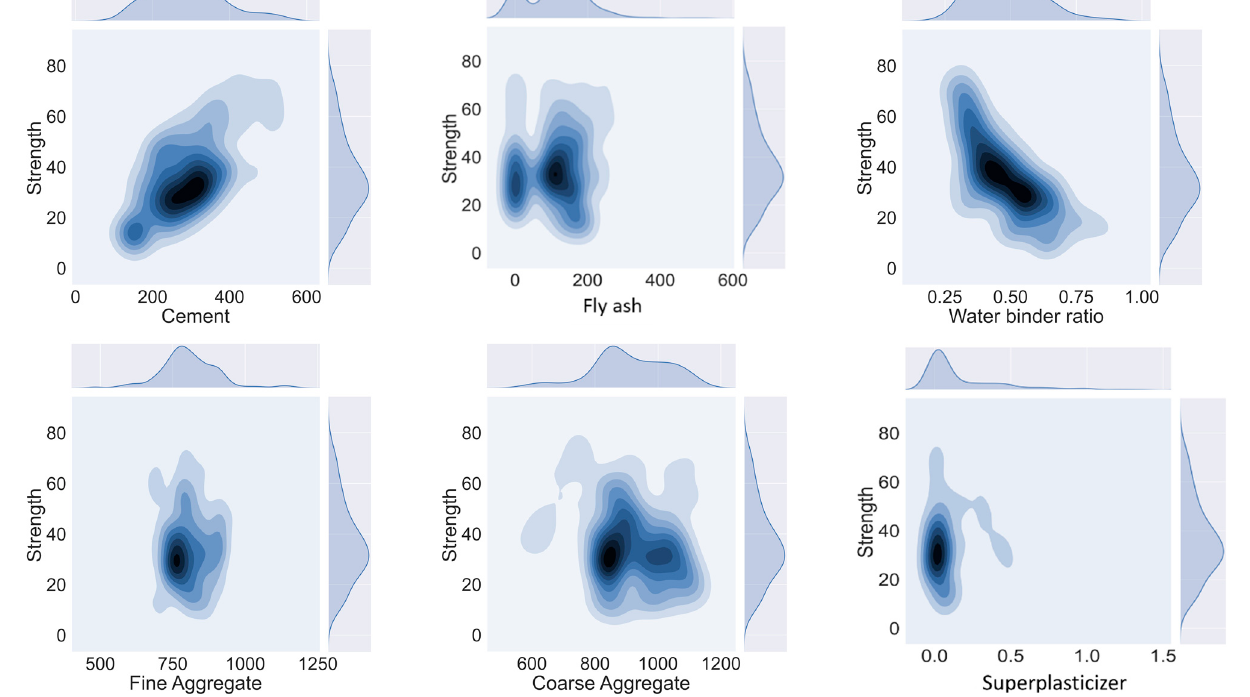
Figure 5. Concentration of input variables in achieving maximum compressive strength of SCC. Table 3. Range of input and output variables.